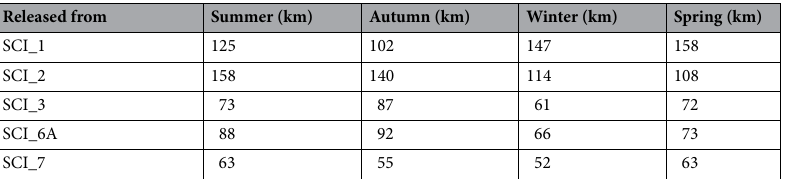
Table 4. Average distance simulated particles travelled in km over a 14 day period (pelagic larval phase is typically < 11 days) when released from the sampling locations during the different seasons. The distance is calculated by using direct distance between recorded